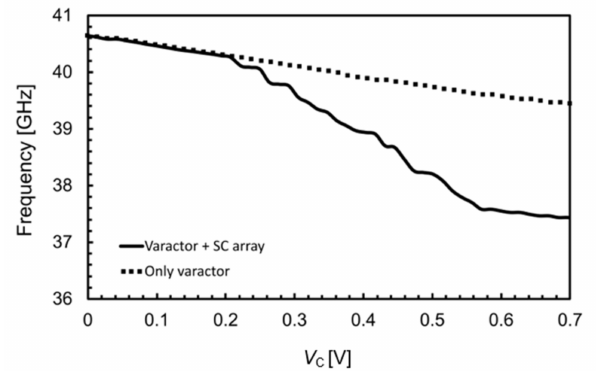
Figure 7. Measured tuning range.